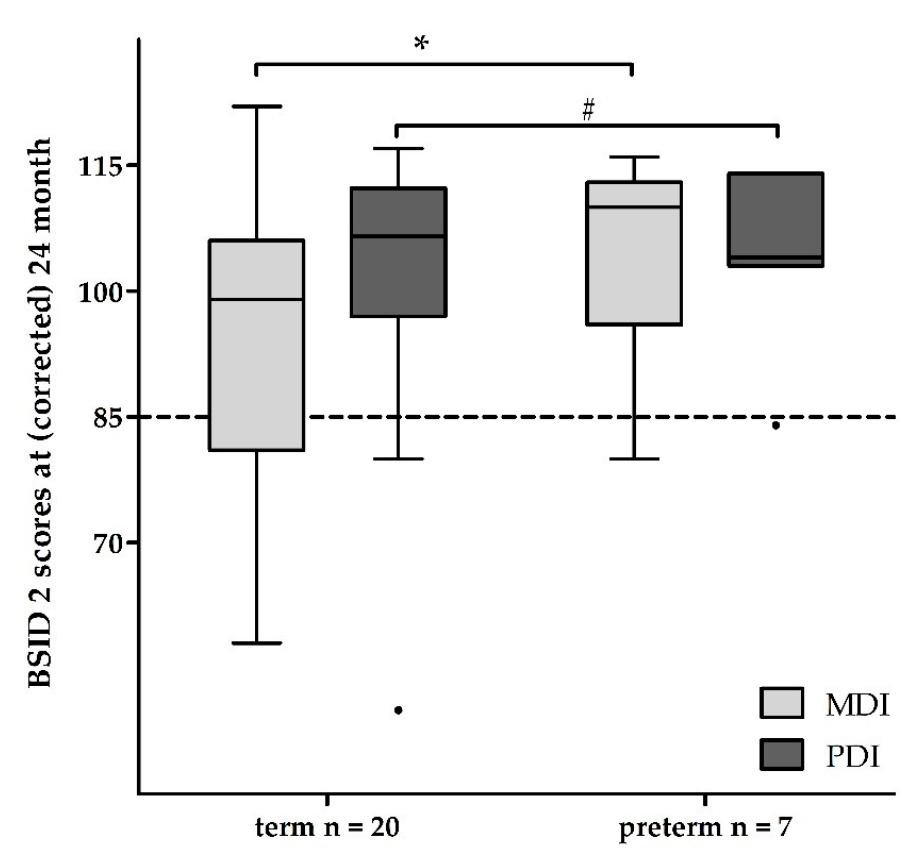
Figure 2. Neurodevelopmental long-term outcome after hypothermia in asphyctic term and late preterm infants at the age of (corrected) 24 months. Term and late preterm infants with hypothermia treatment have an age-appropriate development. Term outliers show developmental delays up to a score of 50, whereas preterm outliers ( • ) show delays up to a score of 85. Abbreviations: n —number, BSID 2—Bayley Scales of Infant Development 2, MDI—mental developmental index, PDI—psychomotor developmental index; * p < 0.05, # p > 0.05.